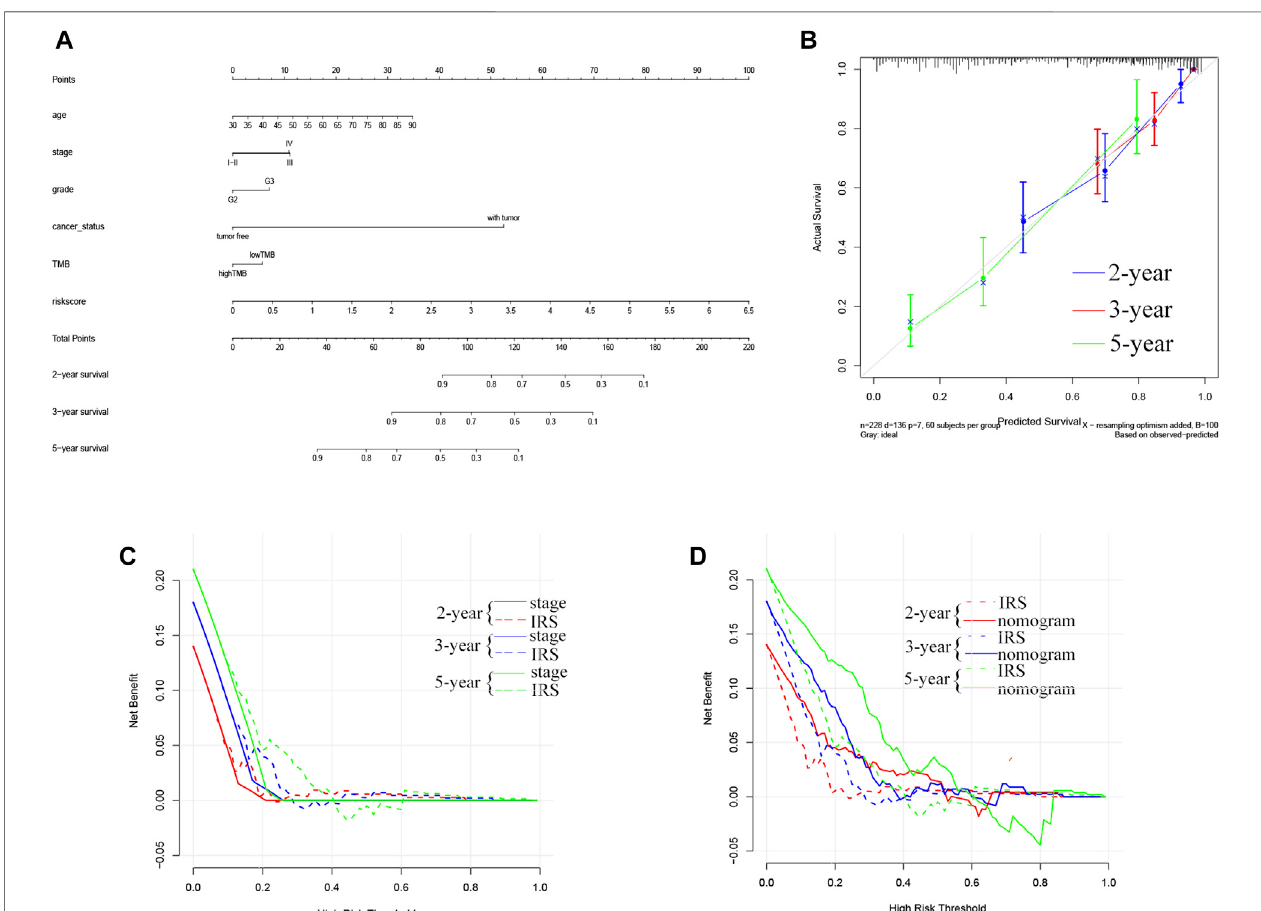
FIGURE 4 | Establishment of the OS nomogram for OC patients. (A) Nomogram for predicting OS of OC. There are eight components in this nomogram: age, stage, grade, cancer status, and risk score. (B) The Calibration curve of the nomogram for predicting OS rate at 2, 3, 5 years (C,D) Decision curve analysis for the evaluation of the net bene fi ts of TNM-stage, IRS and nomogram at 2, 3, 5 years.